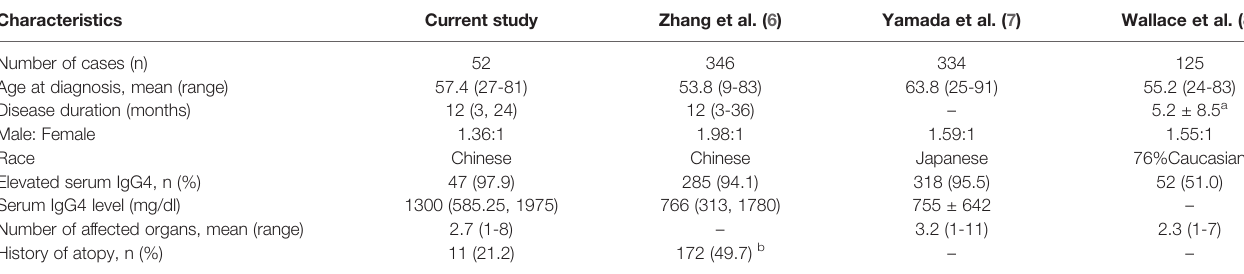
TABLE 1 | Comparisons of clinical characteristics in patients with IgG4-RD in different studies.